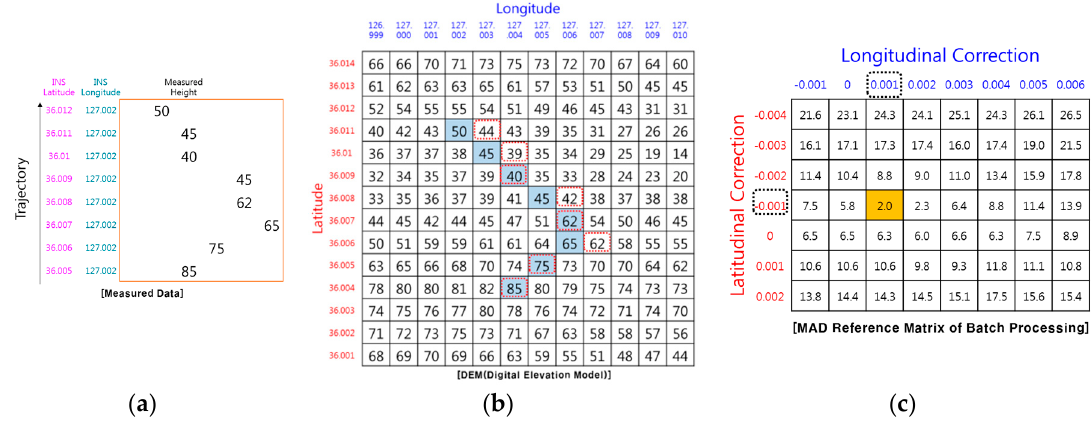
Figure 7. Example on TRN using miscalculated p k : ( a ) Measured terrain profile; ( b ) DEM; ( c ) position correction value.